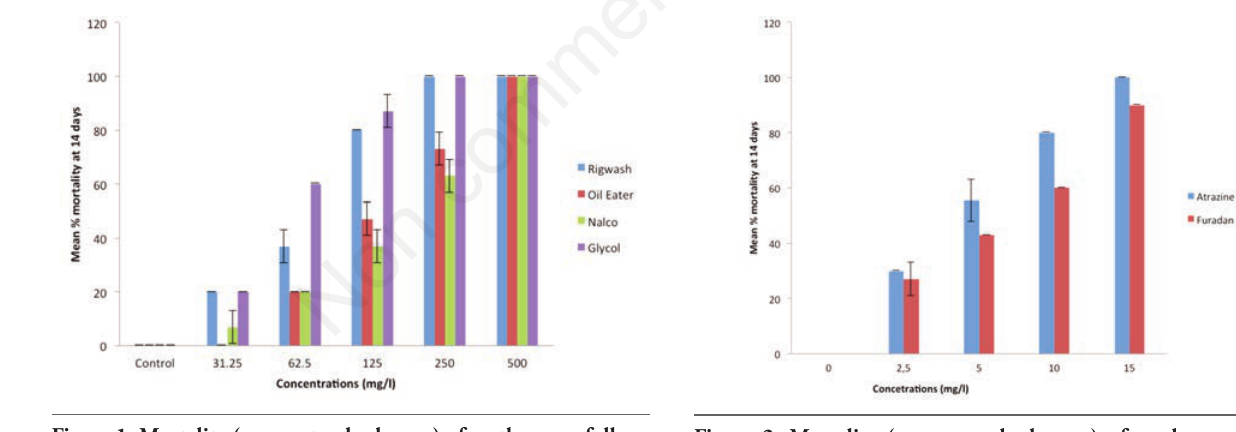
Figure 2. Mortality (mean±standard error) of earthworms fol- lowing a 14-day exposure to